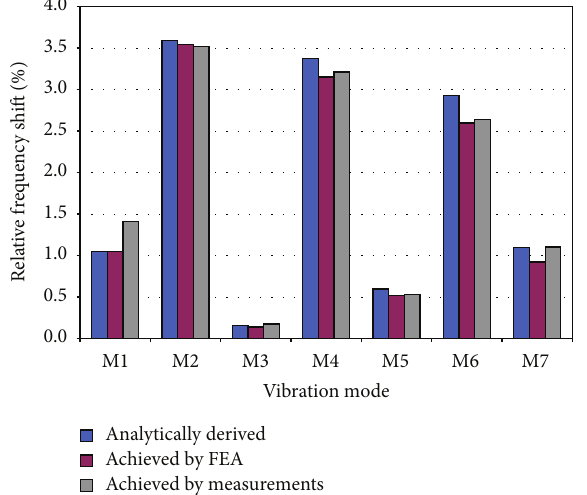
Figure 11: The experimental setup: (a) stand overview; (b) detailed view of the region with added masses.